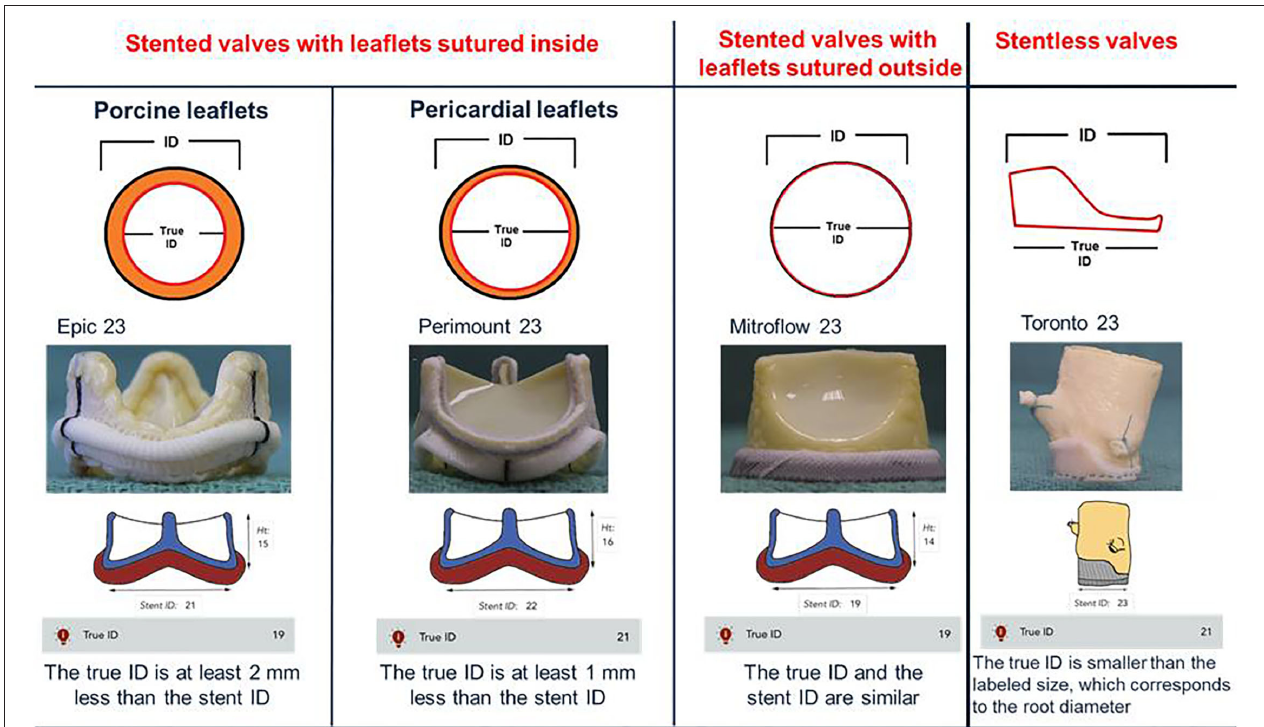
FIGURE 2 | True internal diameter (ID) of stented and stentless surgical aortic valves. In stented valves with porcine leaflets sutured inside (Epic) true ID is at least 2mm < the stent ID. In stented valves with pericardial leaflets sutured inside (Perimount) true ID is at least 1mm < the stent ID. In pericardial valves with leaflets sutured outside (Mitroflow) true ID is the same as the stent ID. In the stentless valves (Toronto), which do not possess a rigid stent frame, the true ID is always smaller than the labeled size, which corresponds to the root